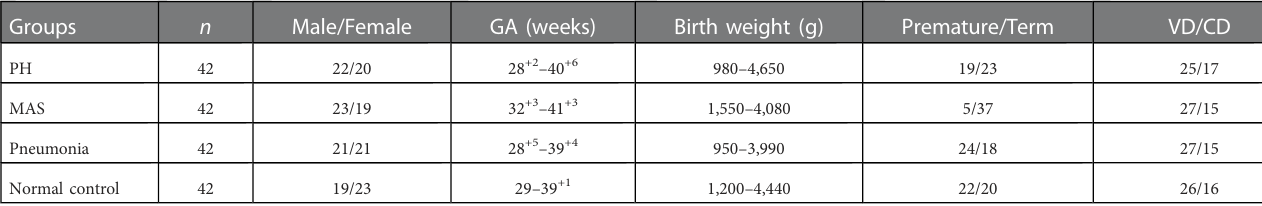
TABLE 1 General demographic data in different groups. Groups